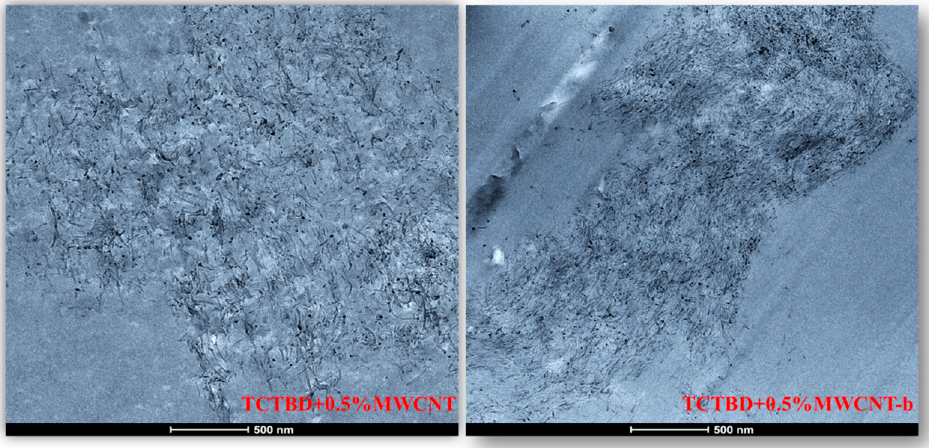
Figure 18. HRTEM pictures of the samples filled with 0.5wt % of MWCNT and MWCNT-b.